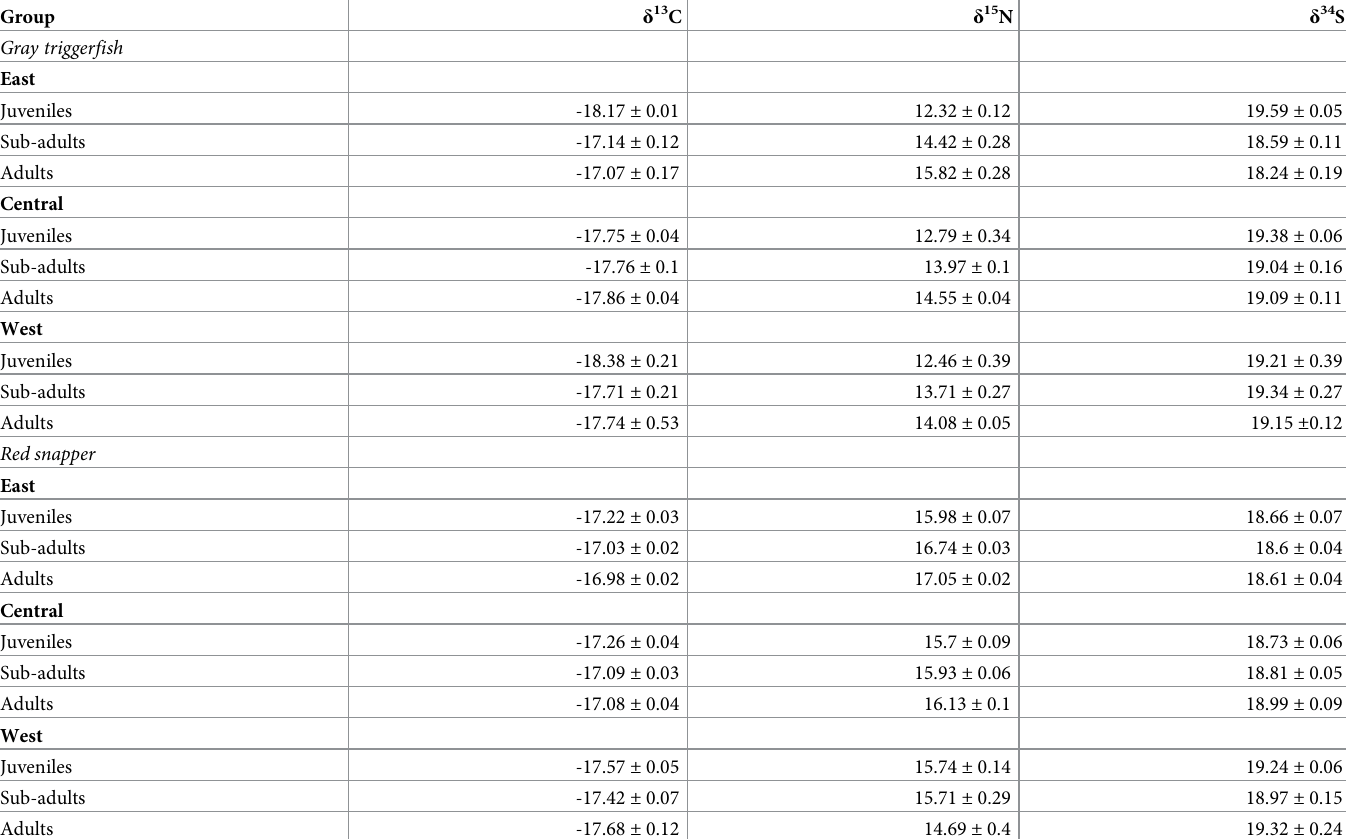
Table 4. Mean stable isotope values for δ 13 C, δ 15 N, and δ 34 S by size class, species, and region.